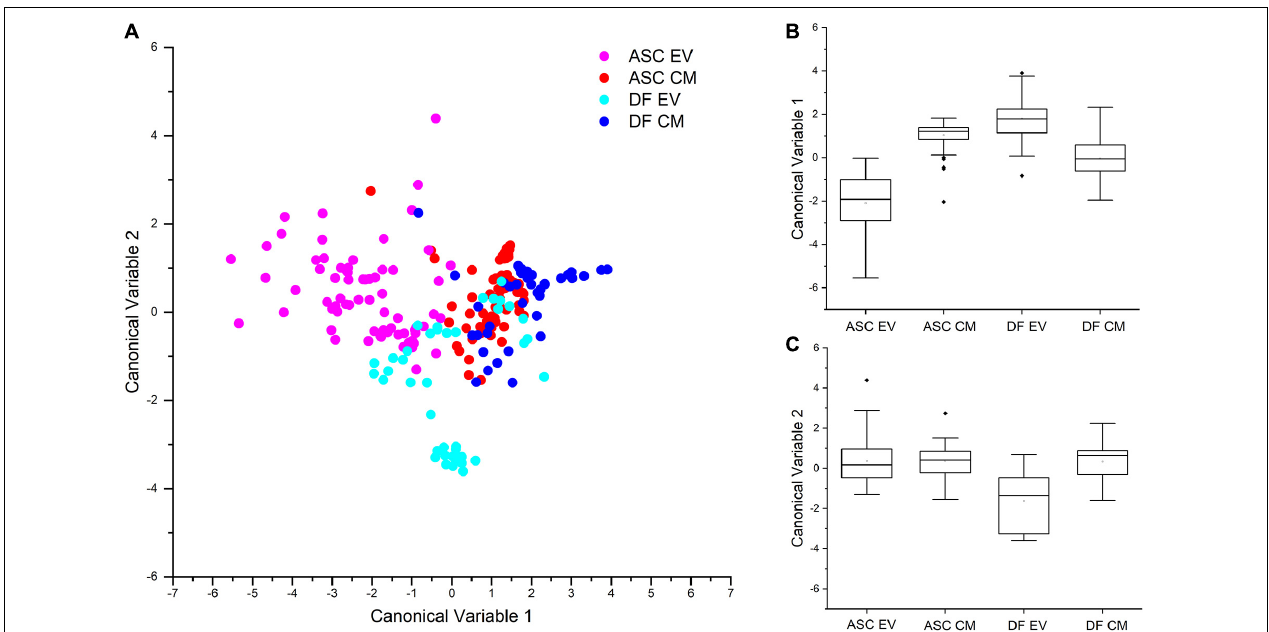
FIGURE 3 | (A) Scatterplot reporting the results of the PCA-LDA multivariate statistical analysis of ASC- and DF-derived secretome products, EVs and CM. Each dot represents one spectrum that has been assigned with canonical variable 1 and canonical variable 2 scores. As reported in the legend, different colors are assigned to spectra based on the source: ASC-derived EVs, pink; ASC-derived CM, red; DF-derived EVs, light blue; DF-derived CM, blue. Partial overlap of blue and red dots shows similarities in the spectra from ASC- and DF-derived CM. B, C: Box plots representing the canonical variable 1 (B) and canonical variable 2 (C) scores obtained after PCA-LDA analysis and the respective results of the non-parametric Kruskal-Wallis test for the analysis of variance. The statistical data demonstrate that CM and EV preparations can be distinguished by the PCA-LDA classification